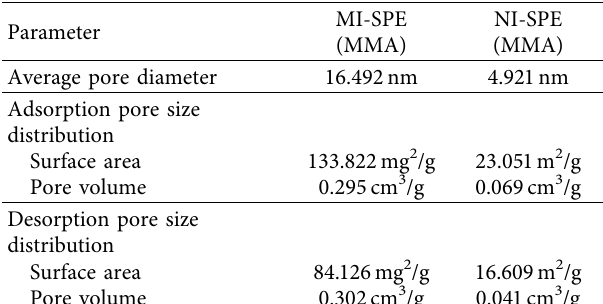
Table 4: Surface area analyser (SAA) results for MI-SPE (mo- lecular-imprinted solid-phase extraction) MMA and NI-SPE (nonimprinted solid-phase extraction) MMA.